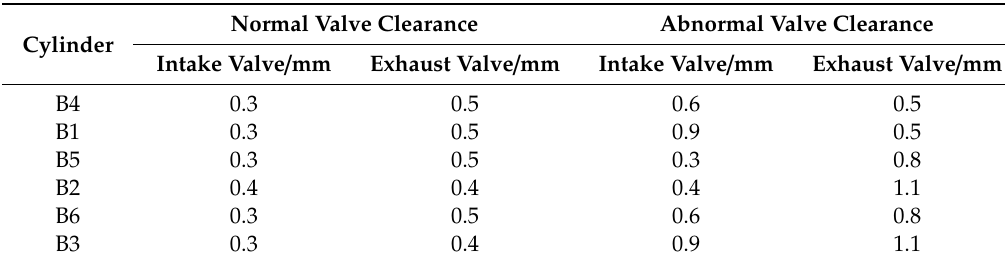
Table 4. The experimental parameters of valve clearance